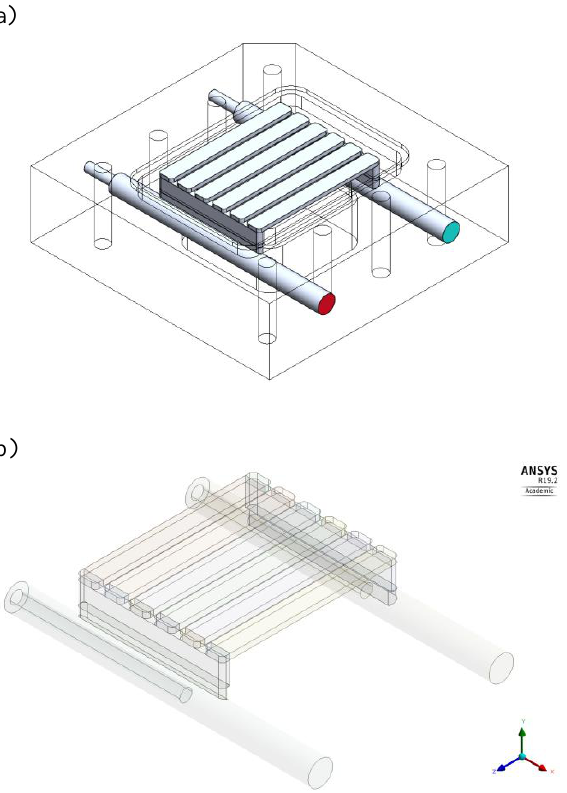
Fig. 6. Schematic diagrams of internal flow volume geometry created in programs: a) SolidWorks, b) Design Modeler, an ANSYS